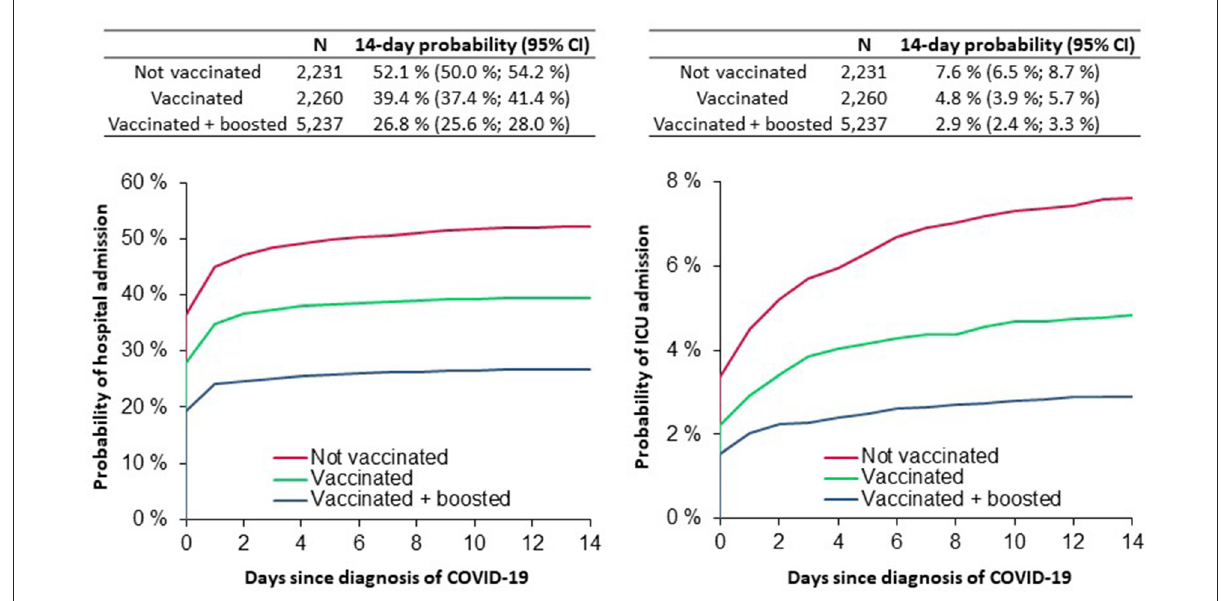
FIGURE1 The probability of hospital/ICU admission in heart failure patients during the Omicron variant wave A.